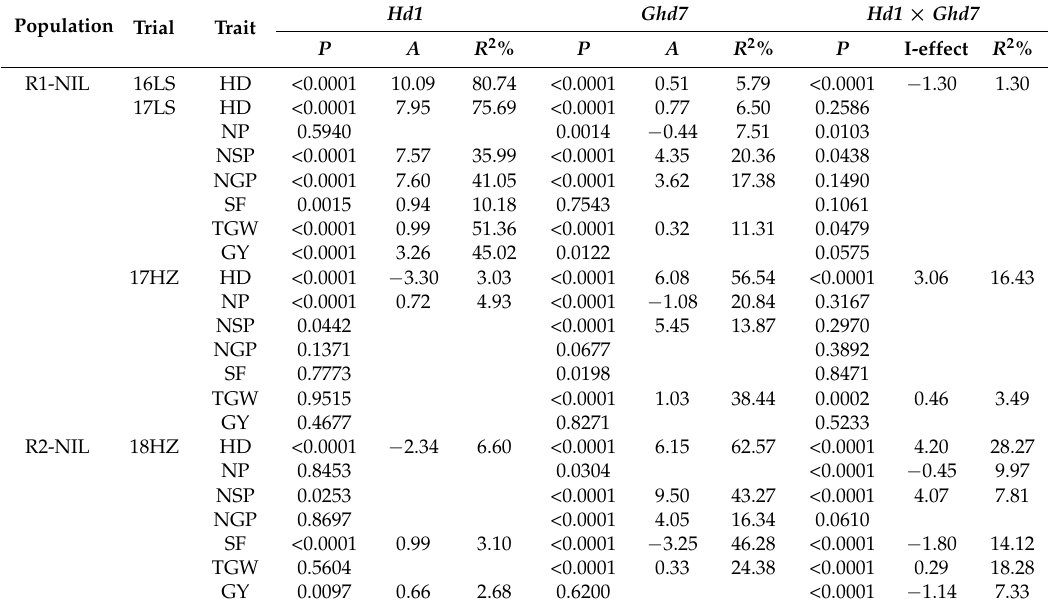
Figure 1. Development of the rice populations used in this study. Table 1. The effects of Hd1 and Ghd7 on heading date and six yield